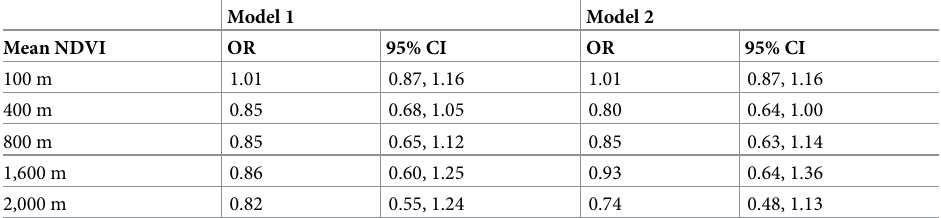
Table 4. Associations between mean NDVI buffer and self-reported heart disease across multiple